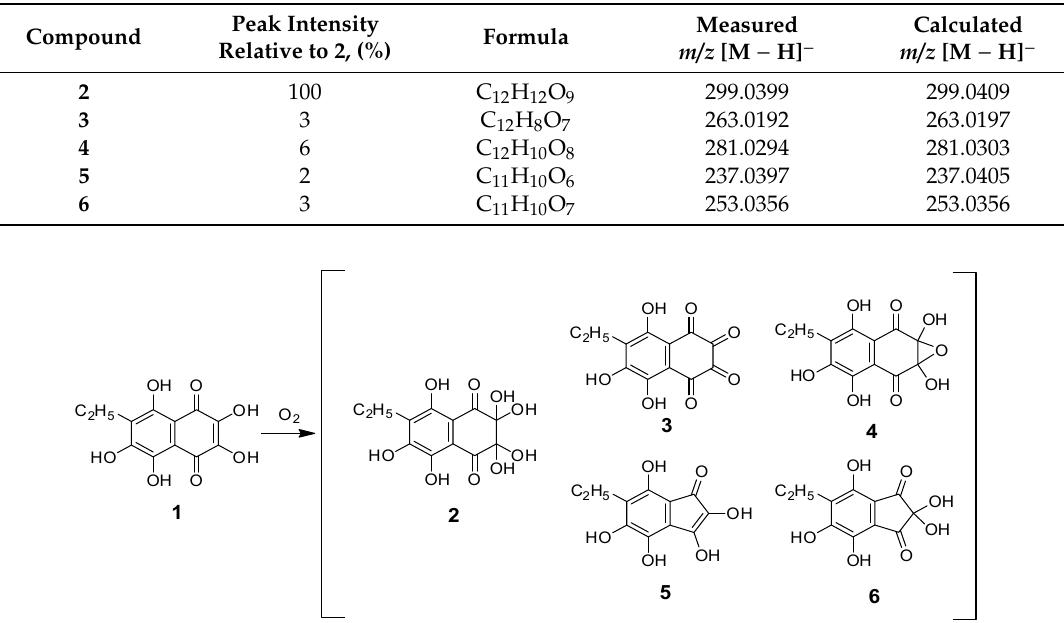
Table 1. High-resolution electrospray ionization mass spectrometry (HR-ESI-MS) characteristics of the chromatographic peaks of Ech A oxidation products at retention time 7.79 min.